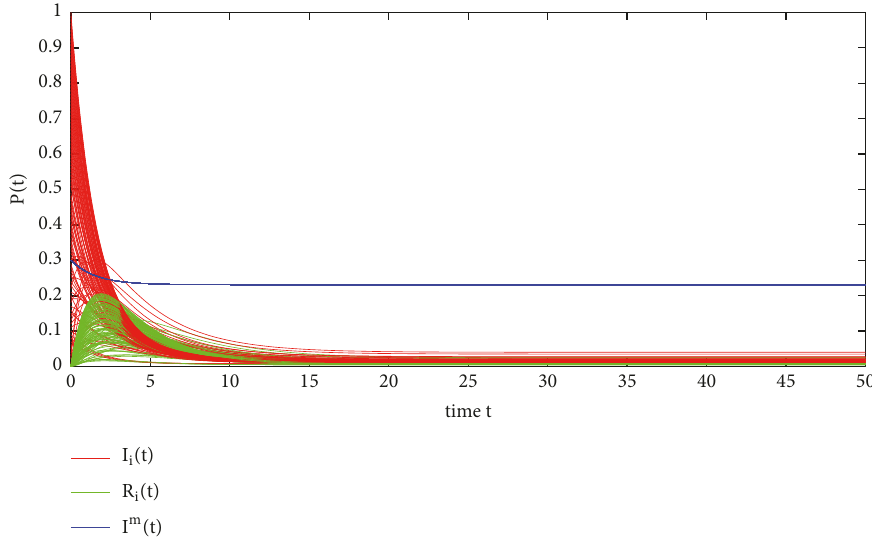
Figure 4: The states 𝐼 𝑖 (𝑡) , 𝑅 𝑖 (𝑡) , and 𝐼 𝑚 (𝑡) of time for BA scale-free networks and random initial conditions.